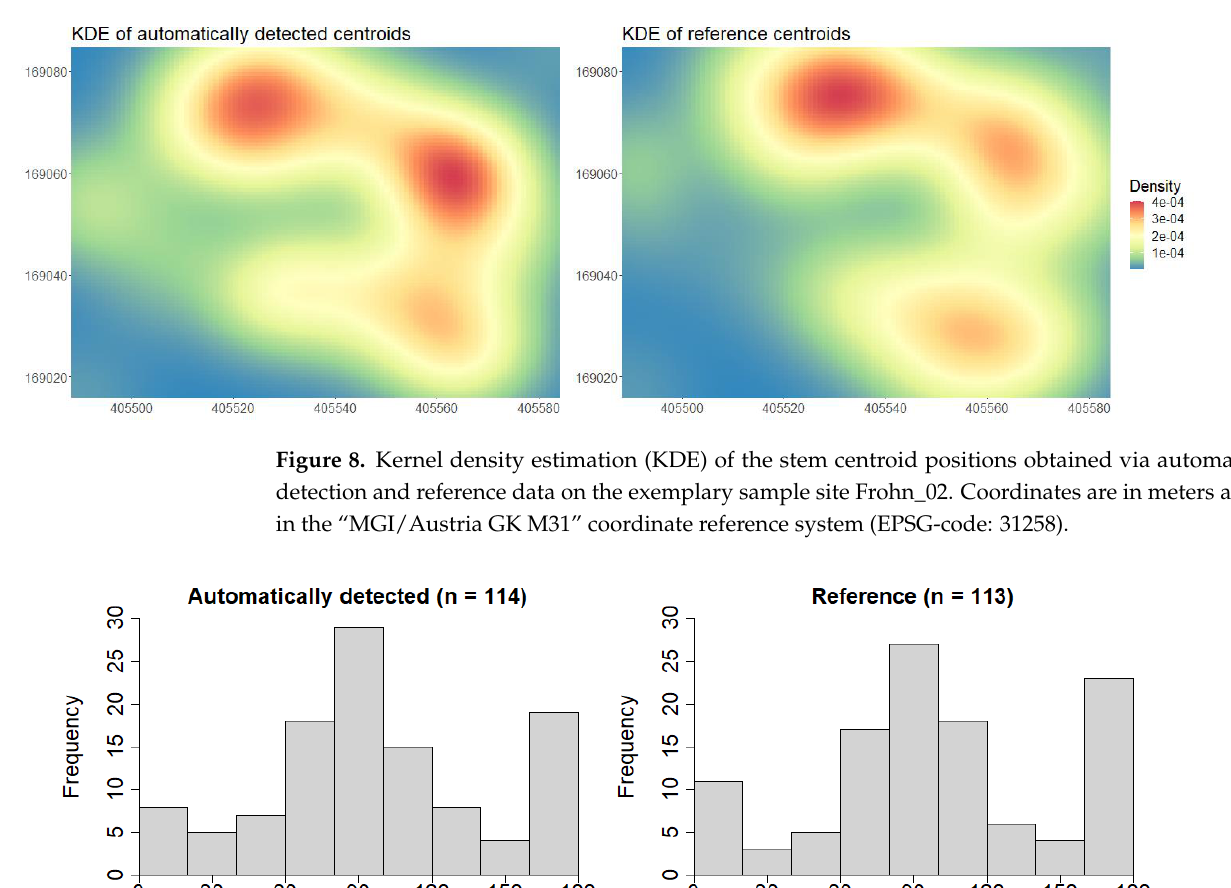
Figure 9. Distribution of the stem orientations (azimuth) in degrees on sample site Frohn_02; 0° indicates a north – south orientation.